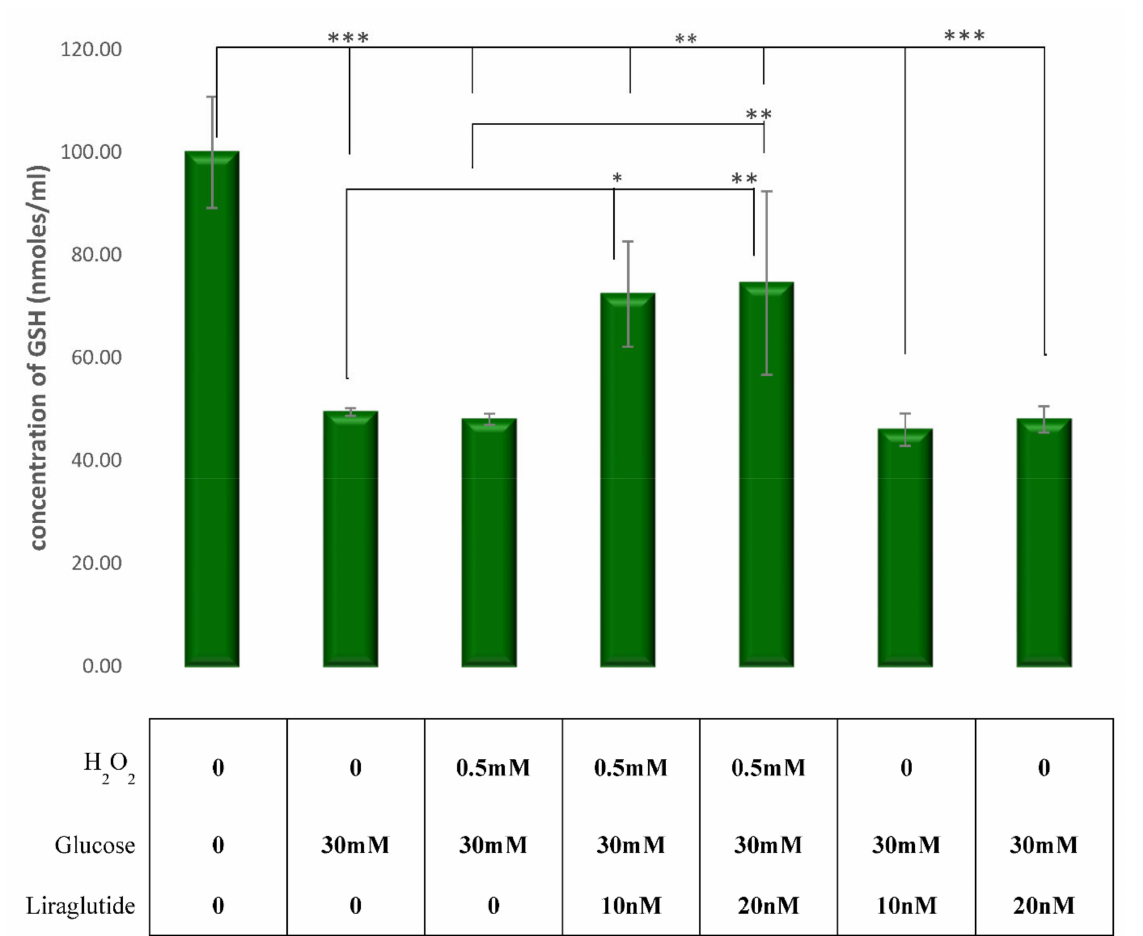
Figure 2. GSH levels in the experimental LLC-PK1-treated cell lines (control vs. HG30 and HG30/H 2 O 2 ; HG30 vs. HG30/Lira10 and HG30/Lira20; HG30/H 2 O 2 vs. HG30/H 2 O 2 /Lira10 and HG30/H 2 O 2 /Lira20). GSH measurements were done by spectrophotometry at 415 nm. One- way ANOVA F(16,70) = 43.68, p = 4.137 × 10 − 25 with Tukey HSD post hoc test; The values are represented in micromole per milliliter as average. Bars assigned with asterisks are statistically significantly different * p < 0.05, ** p < 0.01 *** p < 0.001. Values underneath the x axis represent the amount of compound added in the experiment, and 0 represents that the compound was not added. The data are shown as the means ± SD (standard deviation) from three independent biological replicates. Cellular glutathione (GSH), pig proximal tubule cell line (LLC-PK1), HG (1.5 mM, 30 mM), H 2 O 2 (0.5 mM), Liraglutide (10 nM, 20